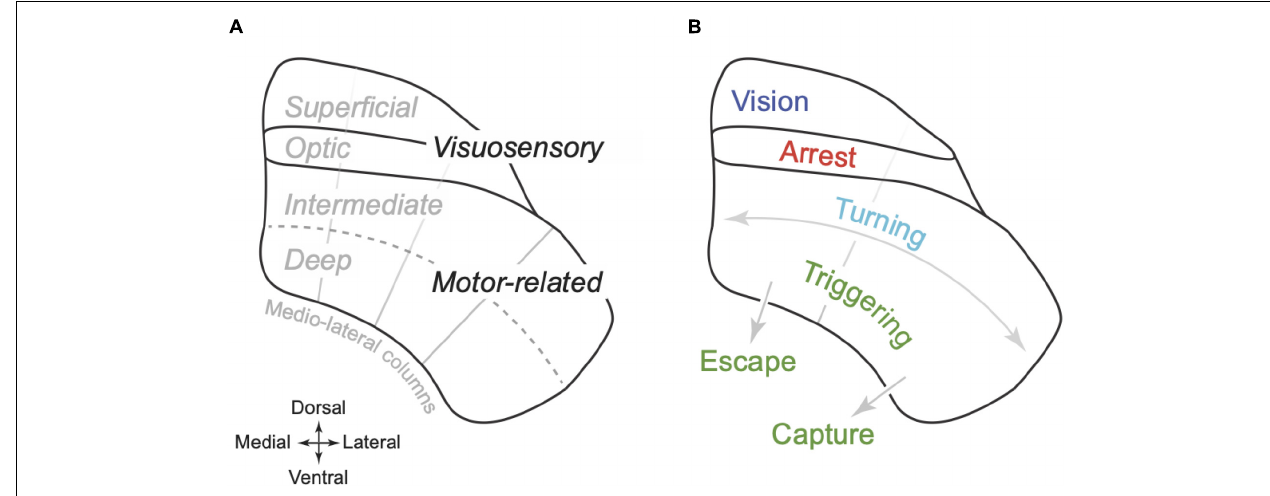
FIGURE 1 | Organisation of superior colliculus in mouse. (A) Schematic coronal section illustrating the dorso-ventral organisation of the superior colliculus (SC) of mouse. The optic layer is ventral to the superficial layers (which includes the superficial grey and zonal layer). Together these layers are termed the “visuosensory SC.” Ventral to the optic layer is the intermediate and then the deep layer. Together these layers are termed “motor-related SC.” The radial grey lines indicate an approximate division of the SC into four “columns” that extend across the layers, partitioning SC on the medial-lateral axis (Benavidez et al., 2021). (B) Proposed functional organisation of SC. The superficial layers primarily support visual analysis; the optic layers primarily organise arrest behaviours; the motor-related SC supports egocentric turning movements as well as the triggering of more complex behaviours, either towards objects including prey (“capture,” lateral SC) or towards refuge (“escape,” medial SC). Turning and triggering may be primarily supported by the intermediate and deep layers,